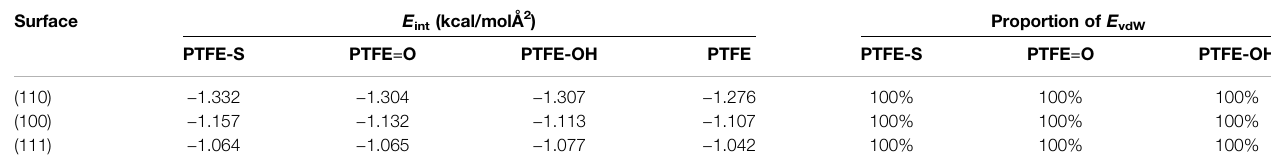
TABLE 1 | The interaction energies of PTFE transfer fi lm on α -Fe surfaces. Surface